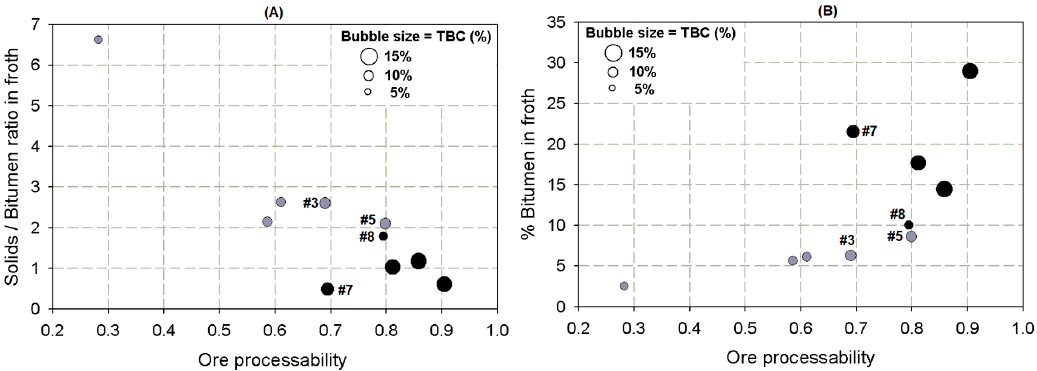
Figure 7. Scatterplots of solids/bitumen ratio and %bitumen in froth versus processability ( A , B ). Black circles = samples with dark froth; grey circles = samples with brown froth. Bubble size relates to %TBC.